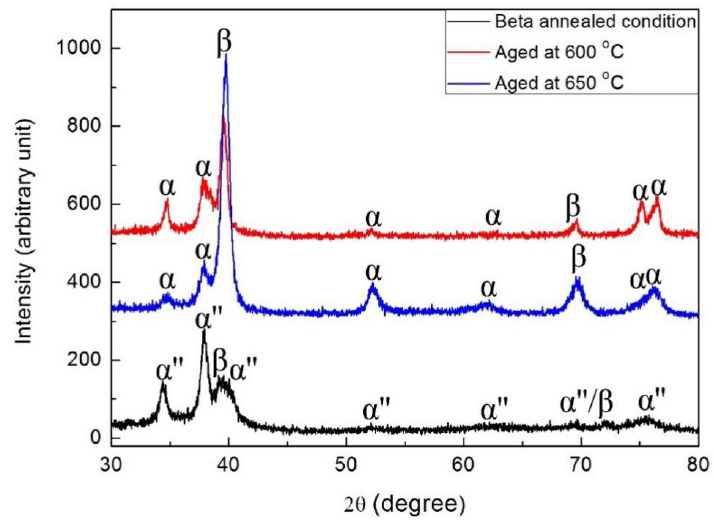
Figure 9. XRD patterns of solution-treated and as-aged Ti6Al4V30Zr alloy.